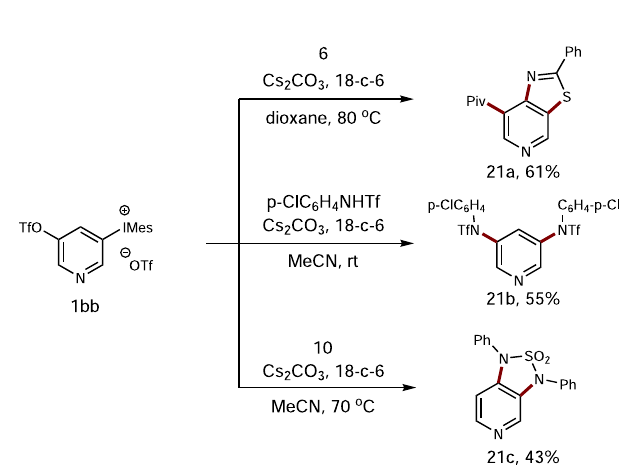
Fig. 6 | Study on pyridiyne precursor 1bb. All reactions are performed on a 0.2mmol scale. Isolated yields are